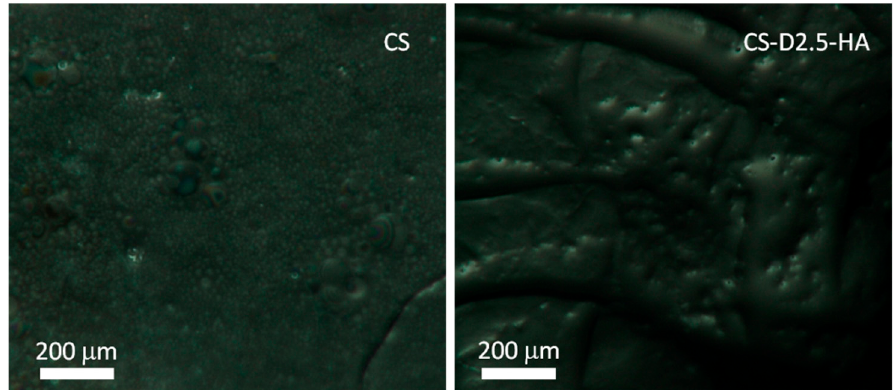
Figure 2. Optical images of CS and CS-D2.5-HA hydrogels.